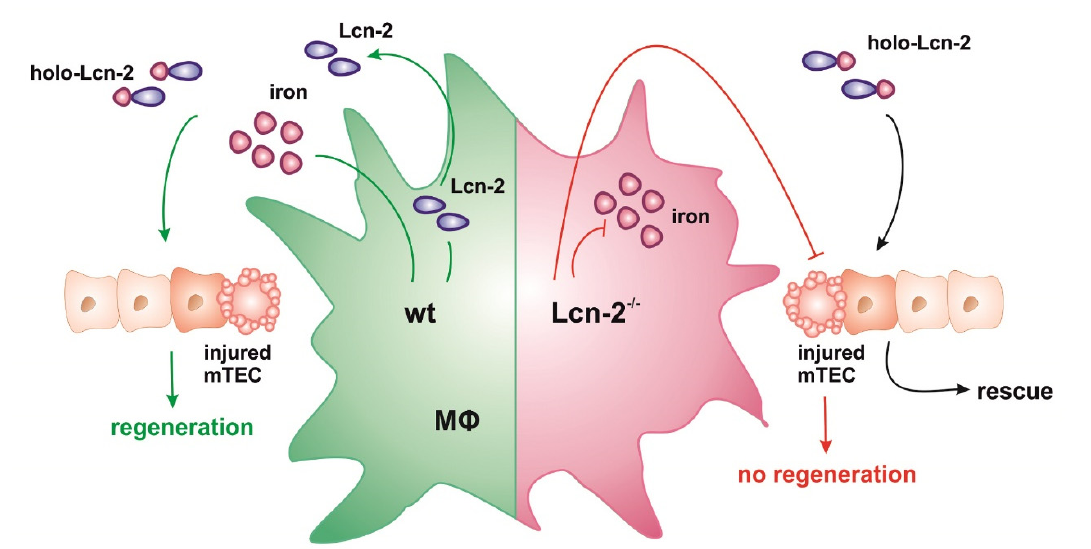
Figure 6. Results summary. Schematic overview of the hypothesis. After the stimulation of wt macrophages (M Φ ) with IL-10, they adopt an iron-releasing phenotype, whereas Lcn-2 − / − macrophages do not release iron to the extracellular space. Wt M Φ also produce Lcn-2 in high numbers that chelates iron and donates these complexes to injured tubular epithelial cells (TEC), where recovery and regeneration are promoted. The addition of iron-containing holo-Lcn-2 rescues the negative e ff ect of Lcn-2 − / − M Φ supernatants.